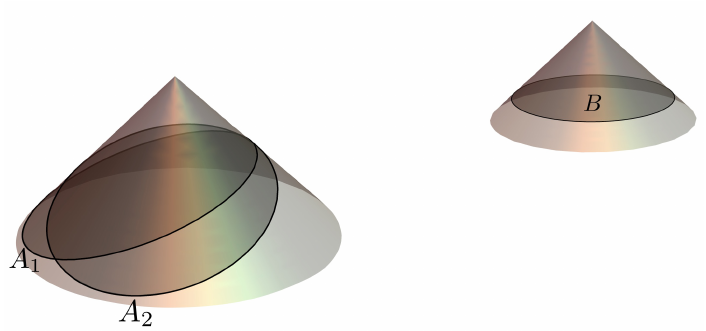
Figure 1 . Two regions A 1 , A 2 with boundary on a null cone and another spatially separated region B